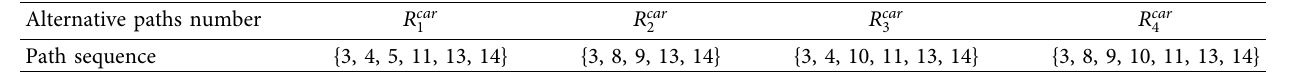
Table 5: Alternative paths for private cars.